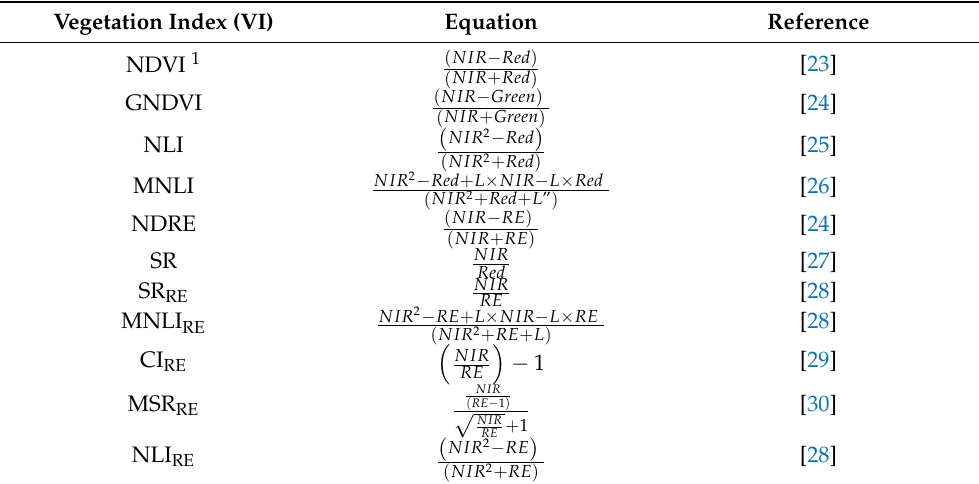
Table 1. Eleven vegetation indices (VI) and their respective equations using spectral bands, and